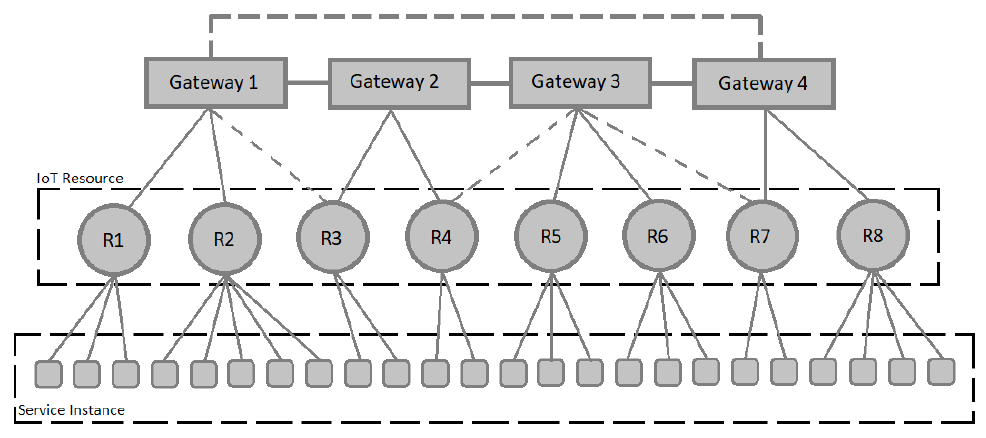
Figure 1. A solution for the IRAP problem